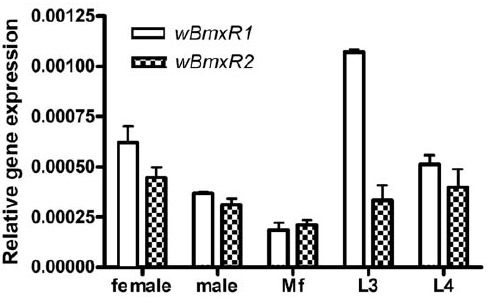
Figure 2. Wolbachia wBmxR1 and wBmxR2 are expressed in various developmental stages of B.malayi . RNA from adult female, male, microfilaria, L3 and L4 stages were analyzed by quantitative RT- PCR. The relative gene expression of wBmxR1 and wBmxR2 was represented relative to Wolbachia 16S rRNA. Data were obtained from triplicate samples and expressed as a mean 6 standard